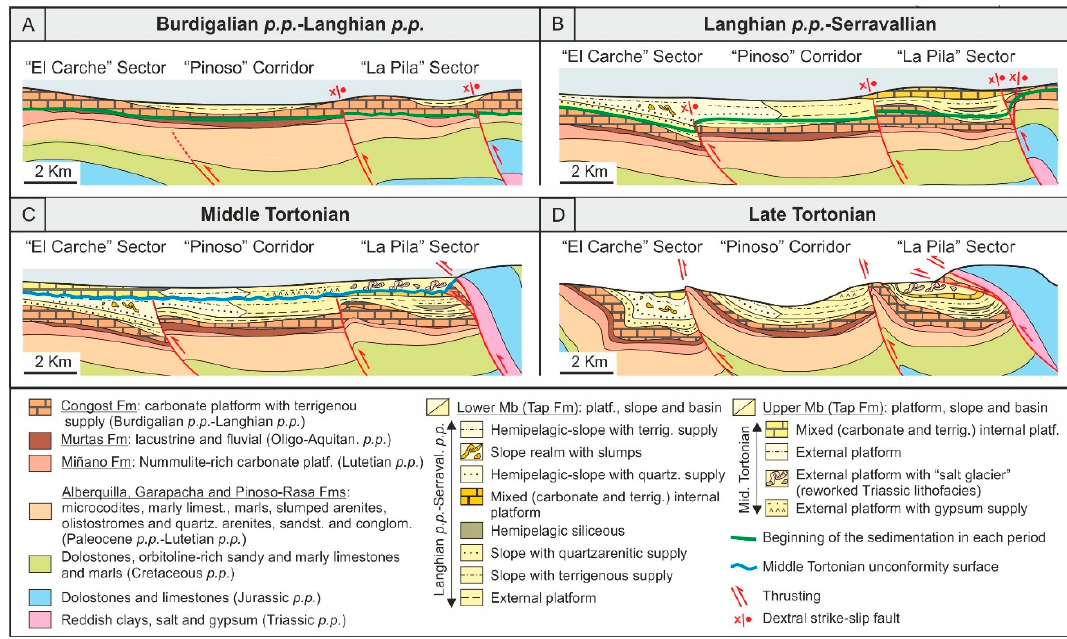
Figure 9. Neogene tectono-sedimentary evolution of the Cenozoic Pila-Carche Basin (Murcia sector) in the eastern EBZ (after Reference [20]; modified). ( A ) Paleogeographic sketch showing a cross-section referable to the Burdigalian-Langhian p.p. interval, ( B ) paleogeographic sketch showing a cross-section referable to the Langhian p.p. -Serravallian interval, ( C ) paleogeographic sketch showing a cross-section referable to the Middle Tortonian, ( D ) paleogeographic sketch showing a cross-section referable to the Late Tortonian.